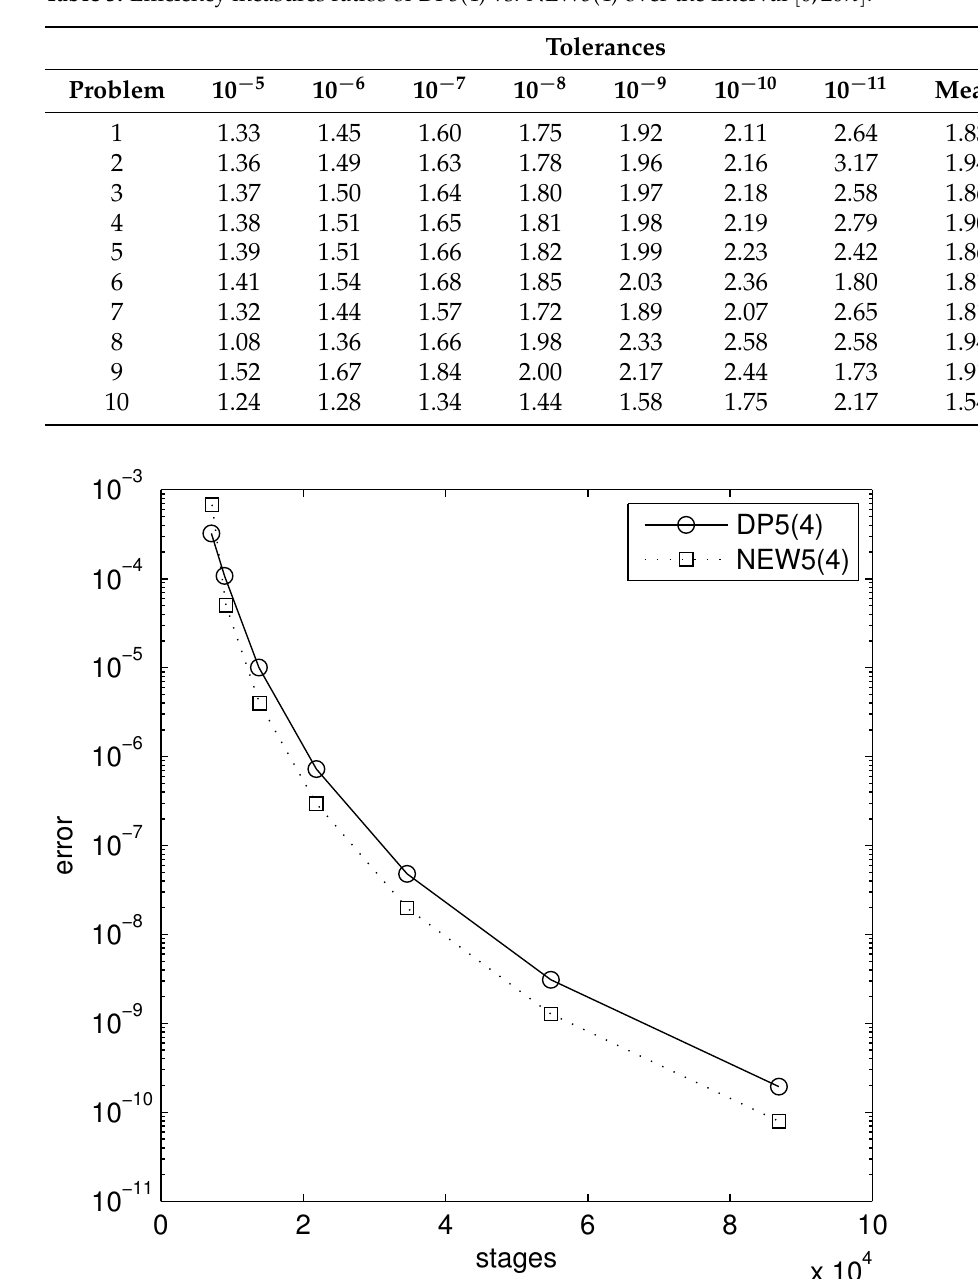
Table 3. Efficiency measures ratios of DP5(4) vs. NEW5(4) over the interval [ 0,20 π ] .